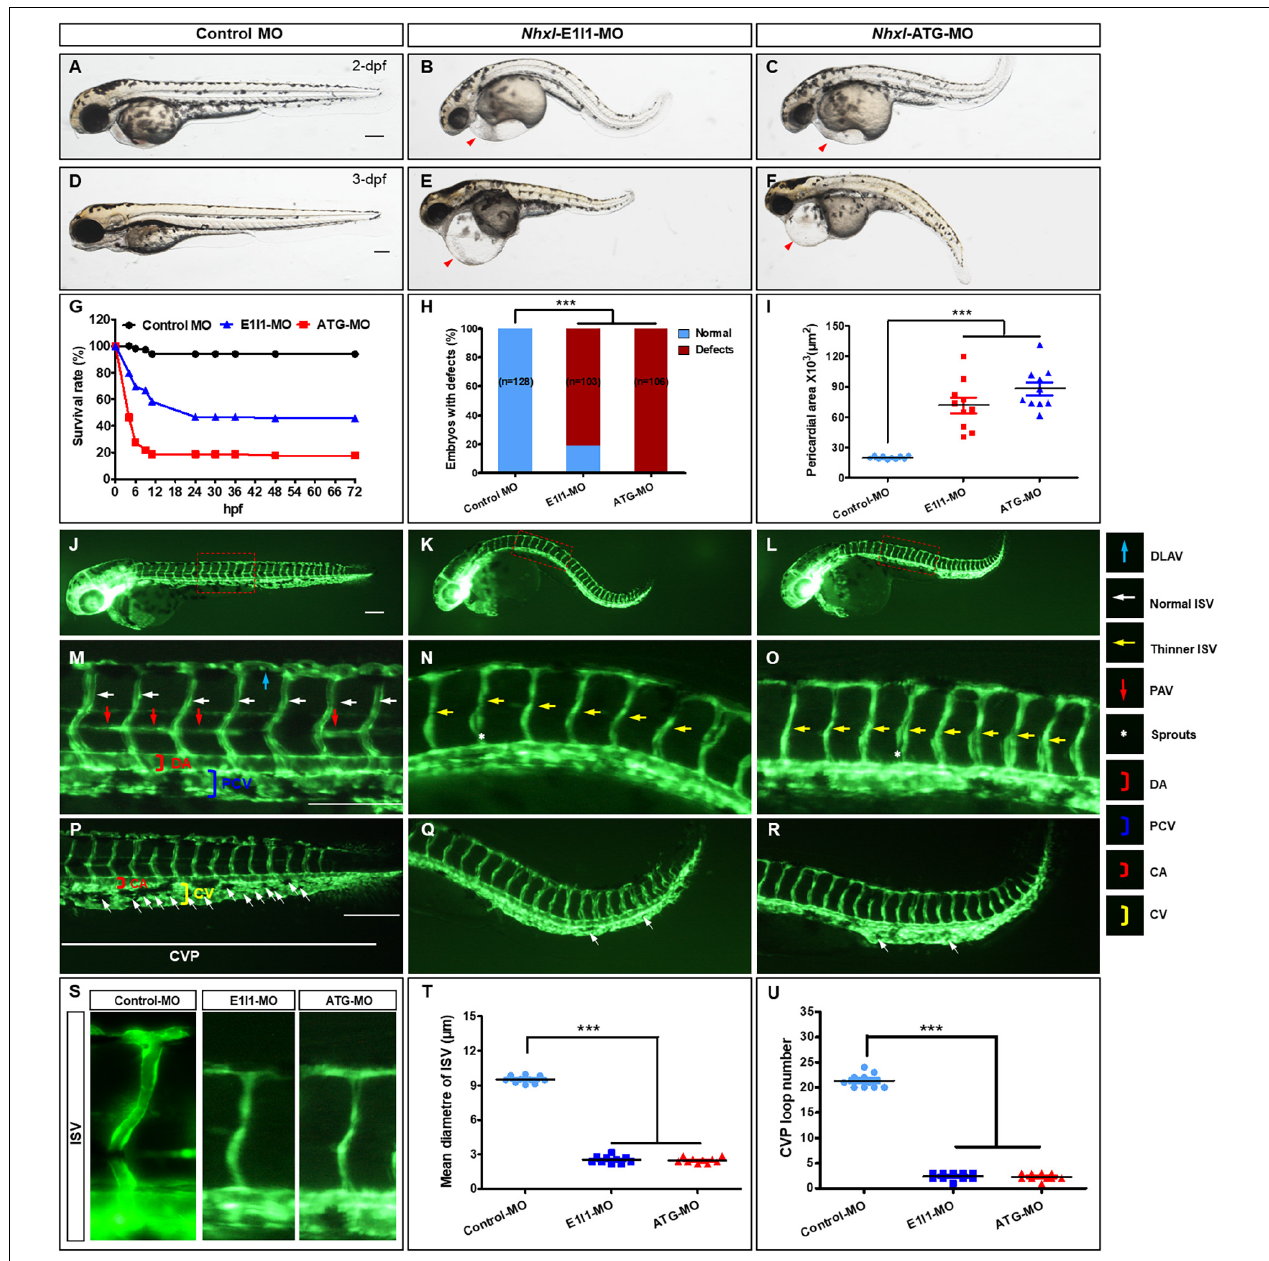
FIGURE 2 | Nxhl regulates vascular development in vivo . (A–F) Gross morphology at 2-dpf and 3-dpf. Compared with control zebrafish, nxhl knock-down causes pericardial oedema ( B,C,E,F , red arrowheads) and circulation defects. Heart beat and circulation in caudal vein (CV) is visible in the control fish, but is abnormal in nxhl morphants ( Supplementary Videos 1, 2 ). (G) A time-course plot of percent survival in control vs. nxhl morphants for 3 days. (H) Shows the percentage of embryos with development defects. (I) Quantification of the pericardial area of embryos. Error bars, mean ± SEM; *** p < 0.0001 ( n = 10; ANOVA). (J–R) Representative fluorescent images of Tg(fli1a:EGFP) y1 embryos at 2-dpf. (J,M) Image of trunk regions taken at 2-dpf, with the vascular structures visualized by eGFP fluorescence and labeled ISV and DLAV showed regular development in the embryo injected with control MO. The boxed regions are shown at higher magnification in the bottom panels. (K,L,N,O) Compared with control MO, embryos injected with nxhl -MO present a lower number of incomplete ISVs and thinner ISVs ( N,O , yellow arrows) and ectopic sprouts (asterisk) of dorsal aorta. In control embryos, the parachordal vessels (PAV) form normally ( M , red arrows). Compared with control, MO knock down nxhl prevents the parachordal vessels (PAV) formation, the precursor to the lymphatic system. In control embryos, caudal vein plexus (CVP) were formed honeycomb-like structures at the tail around 2-dpf (P, white arrows). In contrast, nxhl knock down resulted in specific defects in caudal vein plexus (CVP) formation (Q,R) . (S–U) Quantification of the mean diameter ISVs (S,T) and loop formation at CVP (U) shows significantly decrease in nxhl morphants. Columns, mean; SEM ( n = 10; ANOVA) *** p < 0.0001. DLAV, dorsal longitudinal anastomotic vessels; ISV, intersegmental vessel; DA, dorsal aorta; PCV, posterior cardinal vein; CVP, caudal vein plexus; CA, caudal artery; CV, caudal vein; dpf, days post fertilization. Scale bar, 100 µ m.